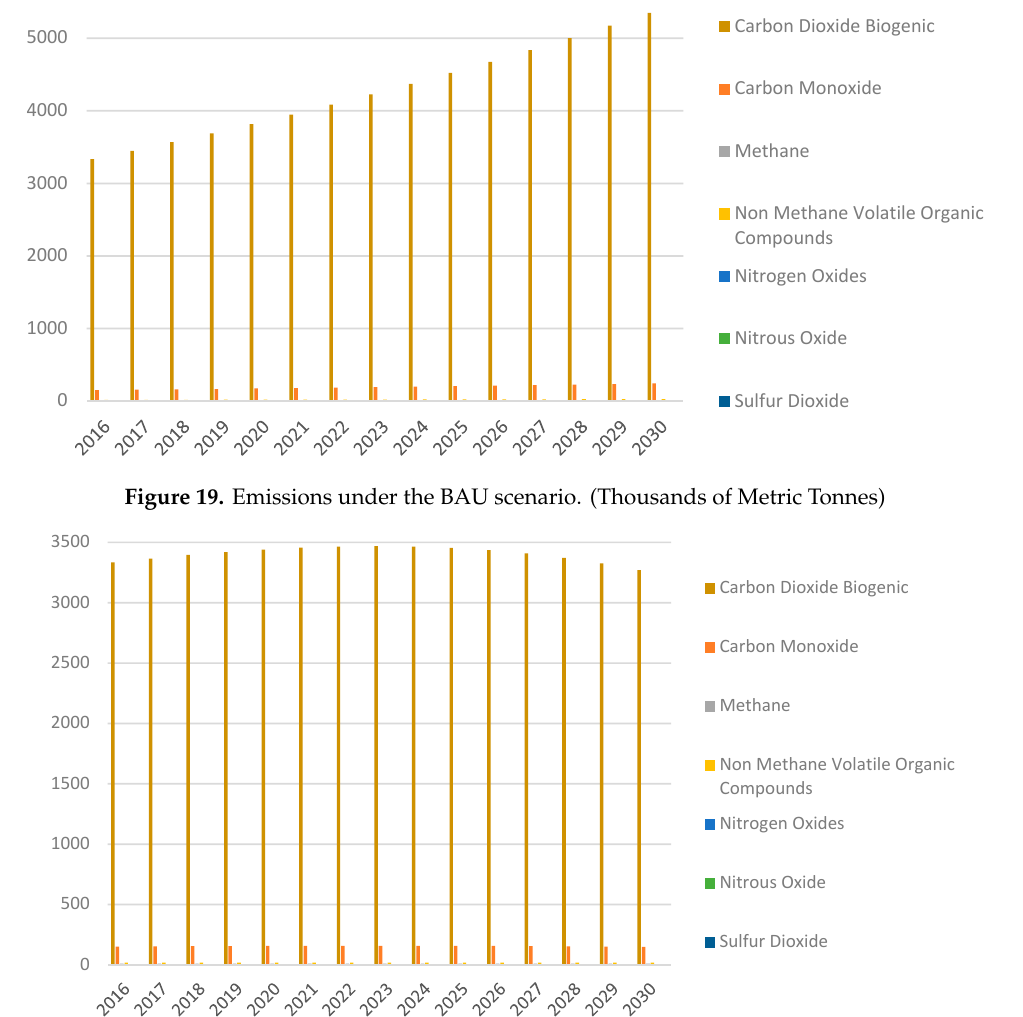
Energies 2020 , 13 , x FOR PEER REVIEW Figure 20. Emissions under the improved stoves scenario. (Thousands of Metric Tonnes). Figure 20. Emissions under the improved stoves scenario. (Thousands of Metric Tonnes) Figure 20. Emissions under the improved stoves scenario. (Thousands of Metric Tonnes)